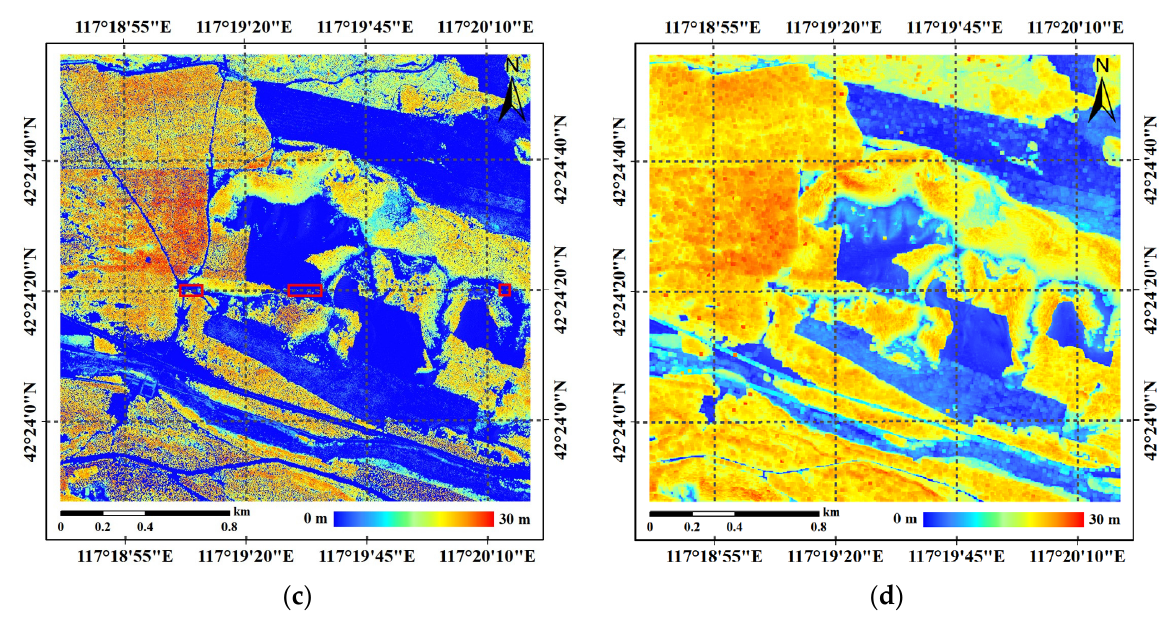
Figure 7. The LiDAR data in the study area: ( a ) LiDAR DTM (spatial resolution: 2 m); ( b ) LiDAR DSM (spatial resolution: 2 m); ( c ) LiDAR CHM (spatial resolution: 2 m); ( d ) H 100 , the 18 m × 18 m window max filtering result based on the LiDAR CHM.